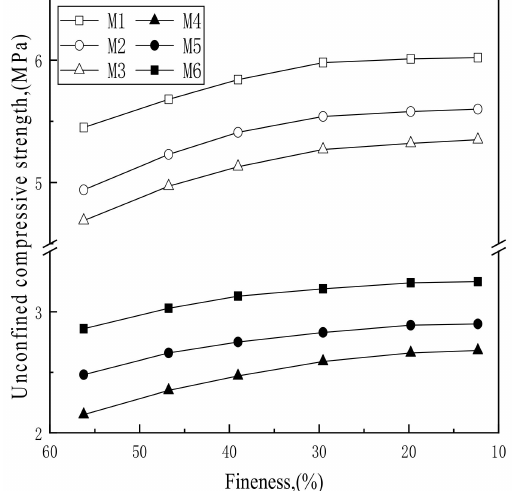
Figure 2. 7-day UCS of cement–PG cementitous materials with di ff erent PG